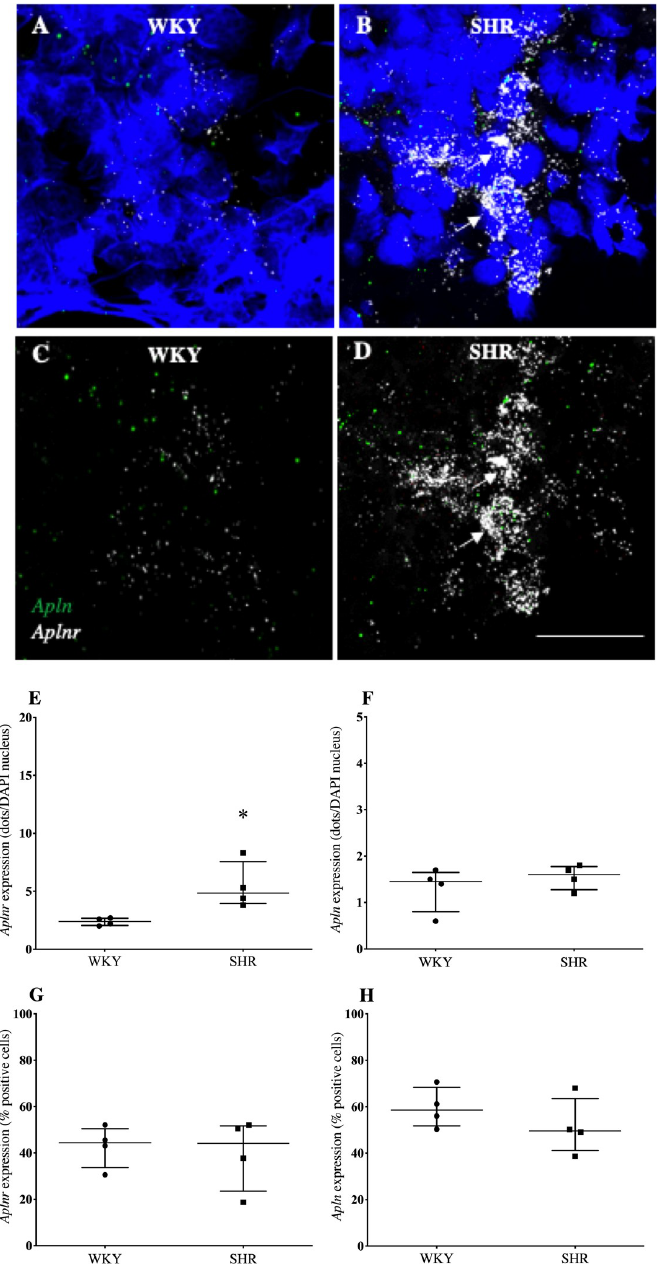
Fig 2. Aplnr and apln expression in the SFO of WKY rats and SHRs. (A-D) Representative fluorescent images showing expression of aplnr and apln in the SFO of WKY rats (A and C) and SHRs (B and D). DAPI: blue, aplnr : white, apln : green. DAPI removed from C and D to highlight distribution of mRNA. Arrows point to representative cells with relatively high levels of aplnr expression. Scale bar = 50 μ m. (E-H) Graphs showing gene expression as a function of dots/DAPI nuclei or percentage positive cells for aplnr (E and F) and apln (G and H) expression. n = 4/ group. Data is median [IQR]. � p < 0.05. in the AP. Up to ~9% of cells in the AP expressed apela (9.4% (28/298 cells) and 5.5% (17/308 cells) of cells were apela -positive in two images of AP from different SHR rats (see Fig 4); 5.8% (16/276 cells) of cells were apela -positive in one image of AP from a WKY rat).